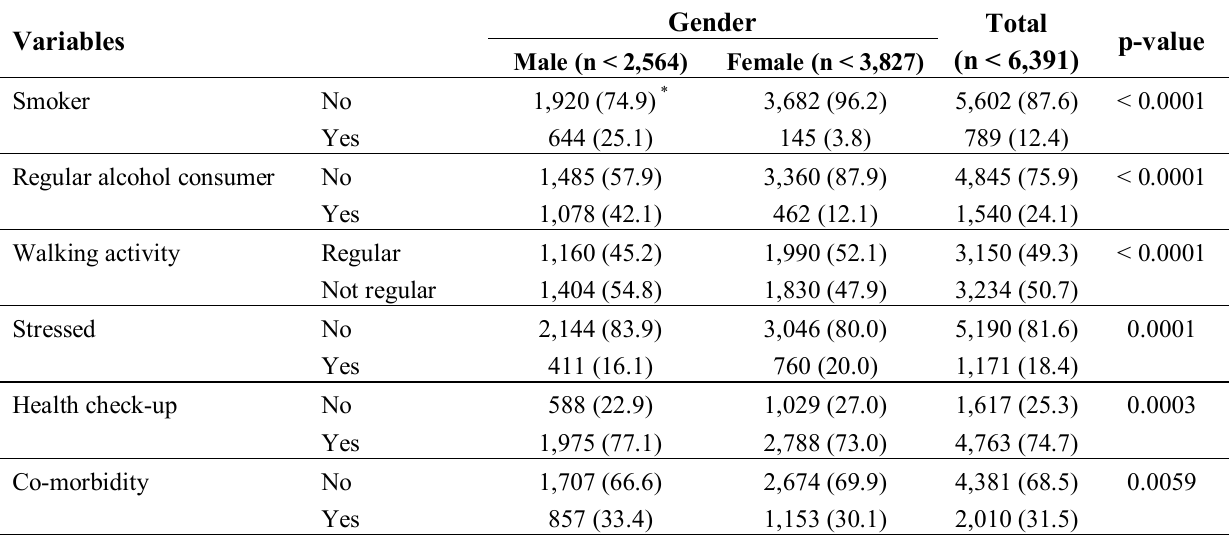
Table 2. Distribution of lifestyles and health-related factors in relation to